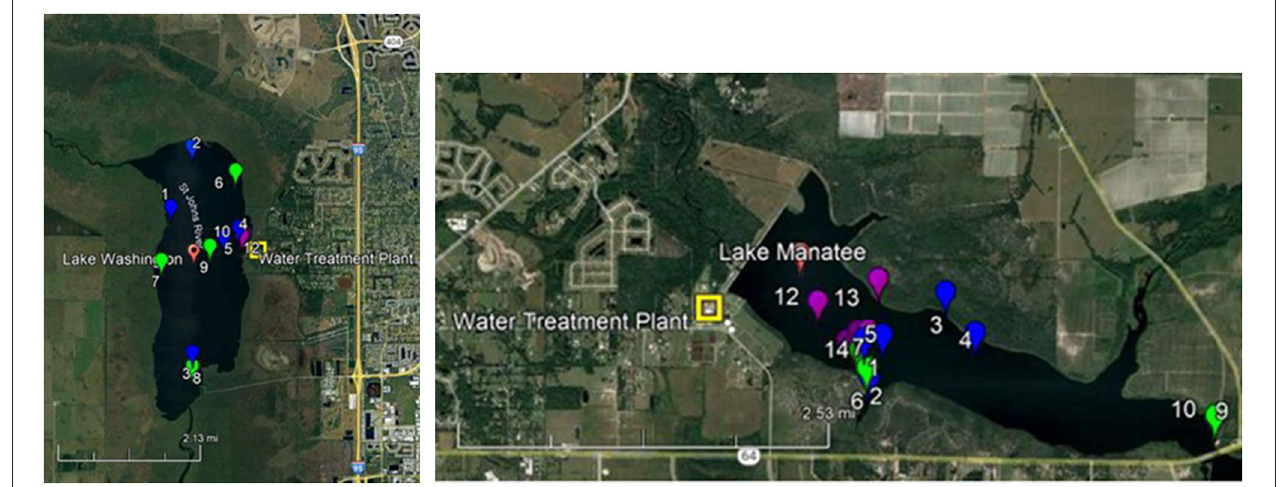
FIGURE 1 | Lake Washington (left) and Lake Manatee (right). Site numbers of environmental samples in Lake Washington and Lake Manatee: = Sites